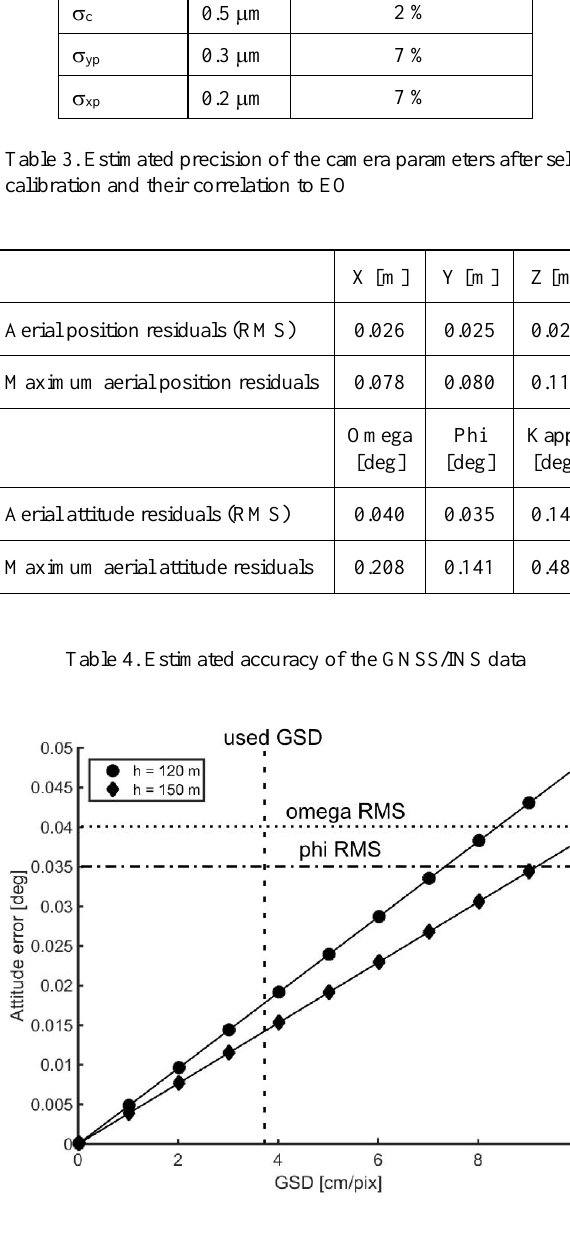
Figure 7. Propagation of roll and pitch errors on the ground from two different flying heights